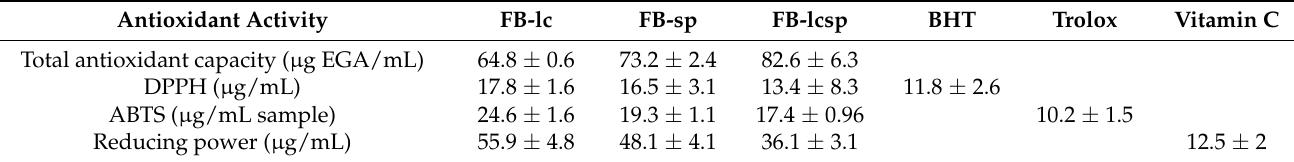
Table 4. Total antioxidant capacity and the free radical scavenging activity of DPPH, ABTS and the reducing power essay of the three fermented beverages. Antioxidant